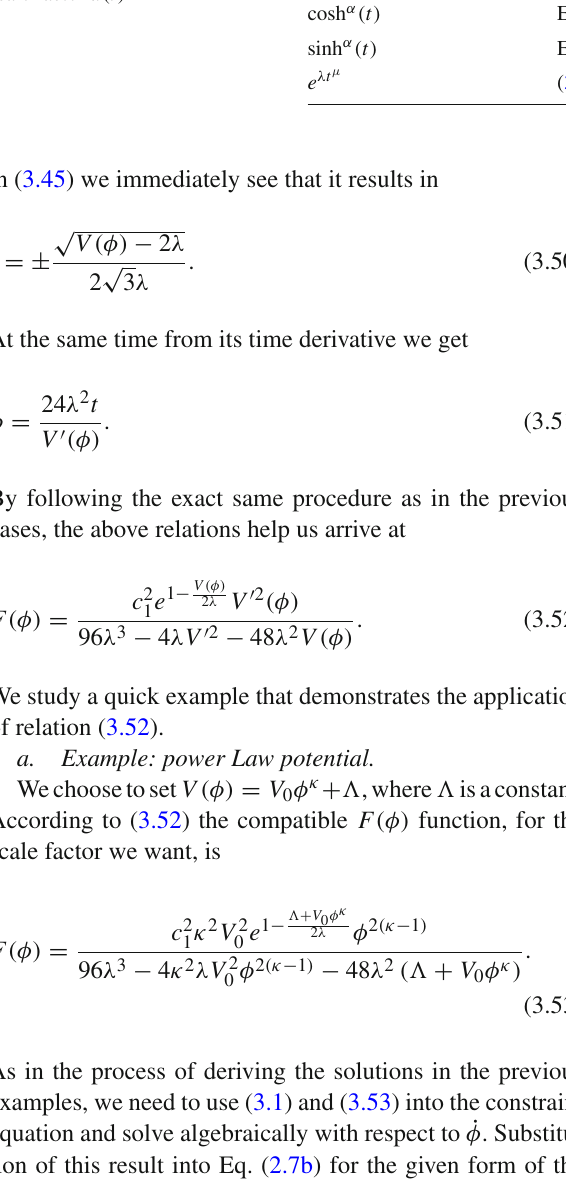
Table 1 Relation between functions F (φ) and V (φ) for specific functional forms of the scale factor a ( t